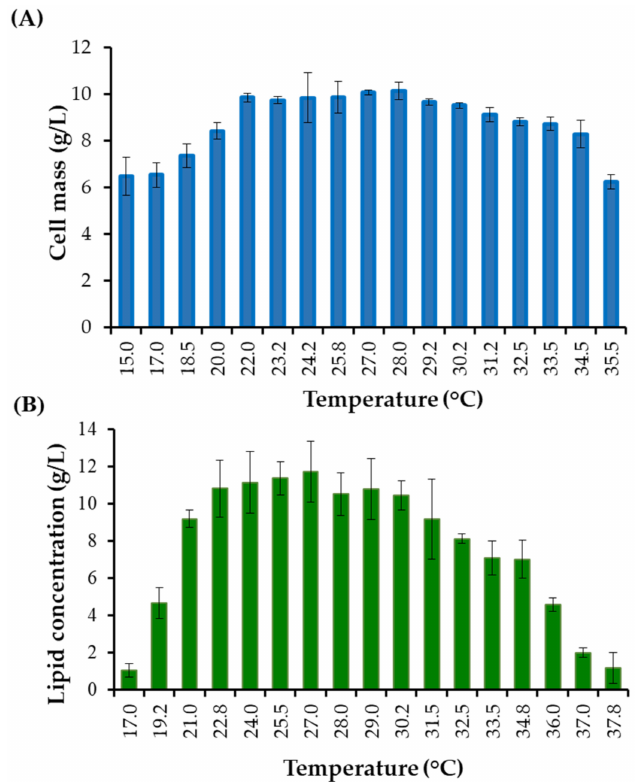
Figure 3. The e ff ect of temperature on (A) cell mass production (g / L) when cultivated in a STH medium